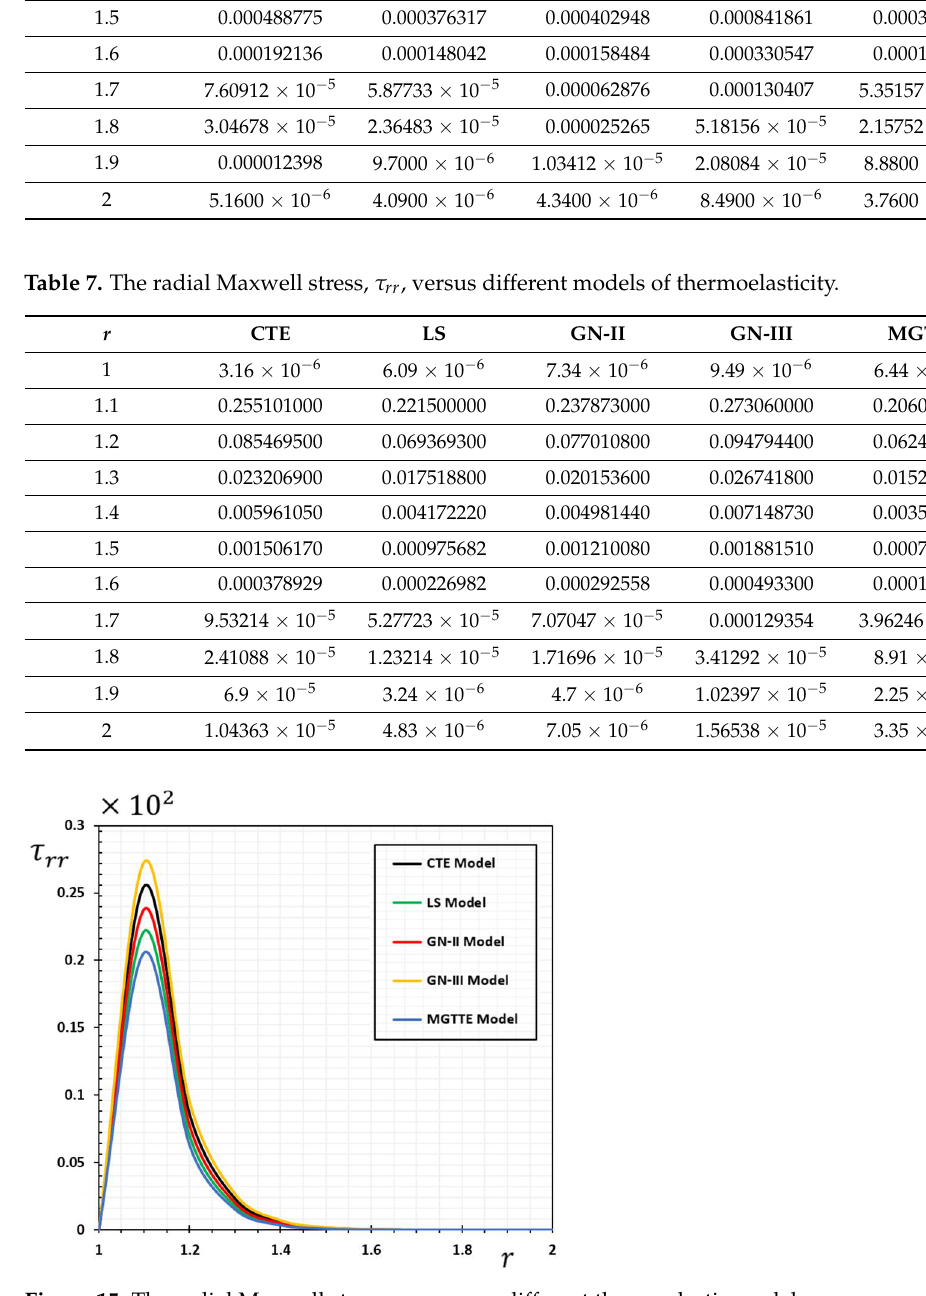
Figure 15. The radial Maxwell stress, (cid:2028) (cid:3045)(cid:3045) , versus different thermoelastic models.